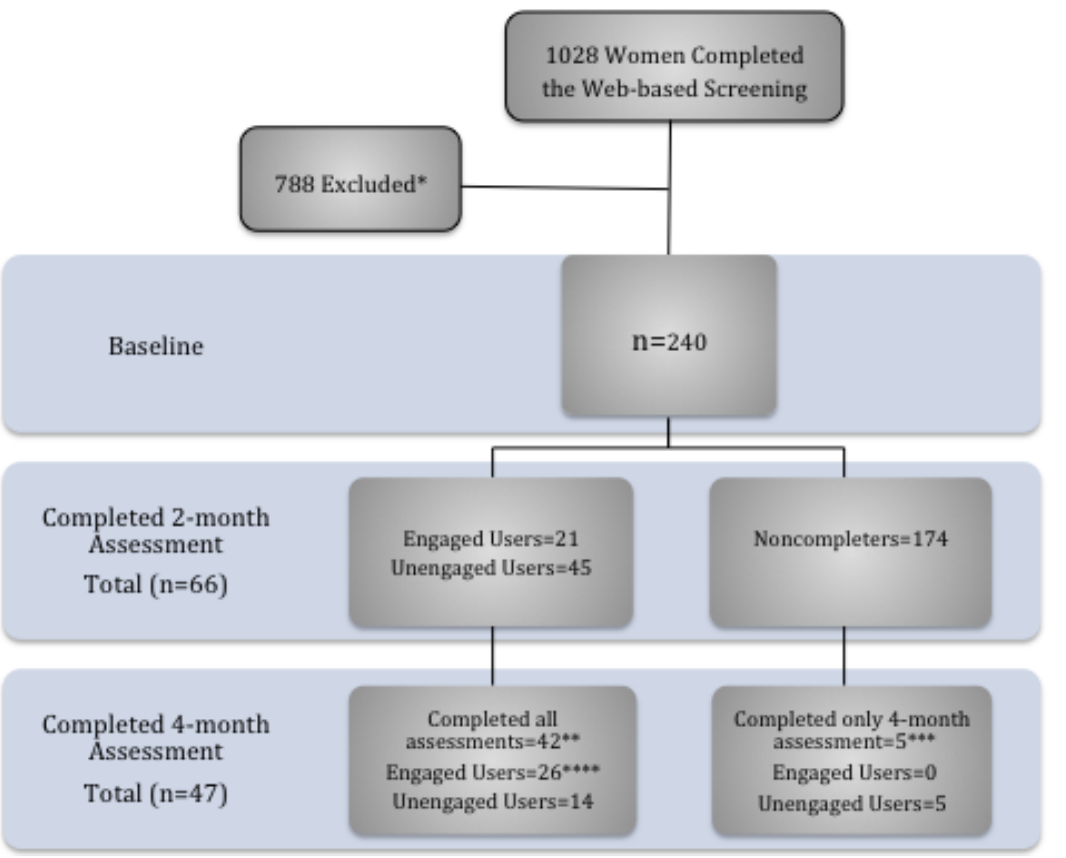
Figure 1. Flow of study participants. *Most common reason for exclusion was having a medical condition such as hypothyroidism. **Two participants were excluded because of being on a new diet. ***Five participants’data were not included in the final analysis because of failure to attend the